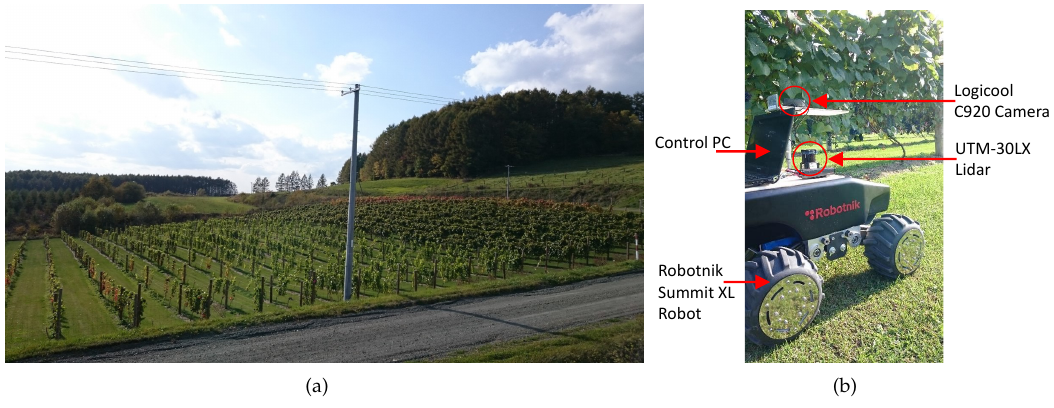
Figure 10. Experiment setup: ( a ) vineyard where experiments were performed; and ( b ) robot